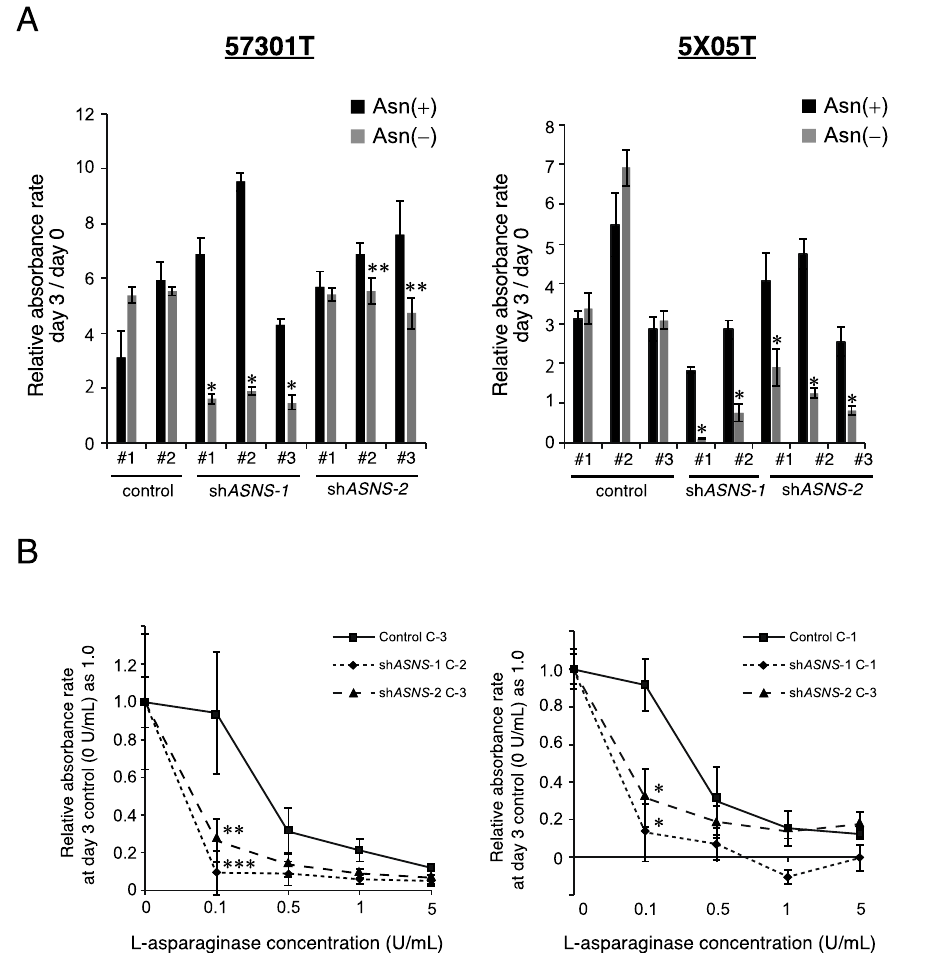
Figure 3. Inhibition of ASNS suppresses spheroid growth in vitro. ( A ) Cell proliferation measured by CCK-8 assay. The bar graph shows the relative absorbance rate on day 3 compared with day 0. Student’s t test, p * < 0.01, p ** < 0.05. ( B ) Cell proliferation measured by CCK-8 assay. Cells transfected with control or two independent sh ASNS vectors were treated with various concentrations of L-Asp. Student’s t test, p * < 0.01, p ** < 0.05, p *** = 0.05.